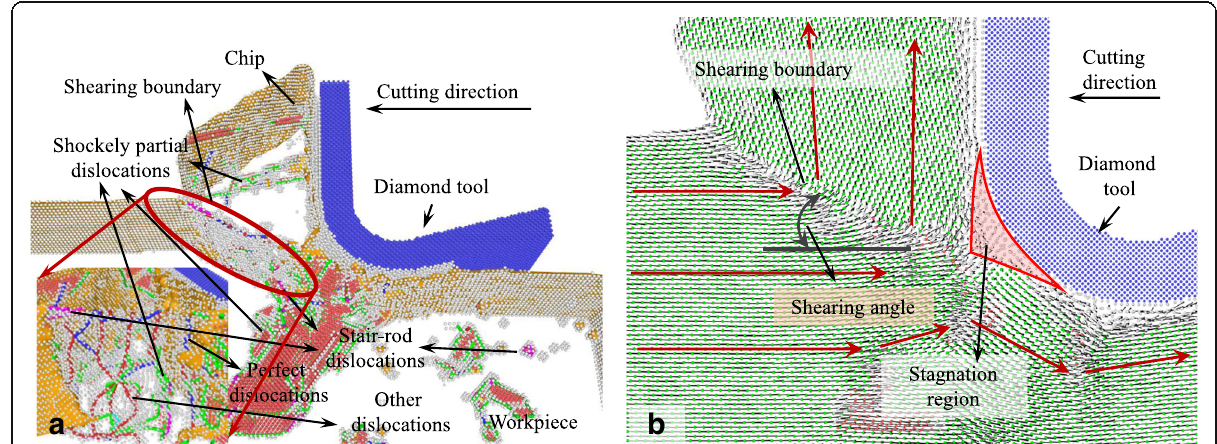
Fig. 6 a Snapshots of the microstructure evolution at cutting direction of {110}<1-10>, b displacement vector sliced at 4 nm in z